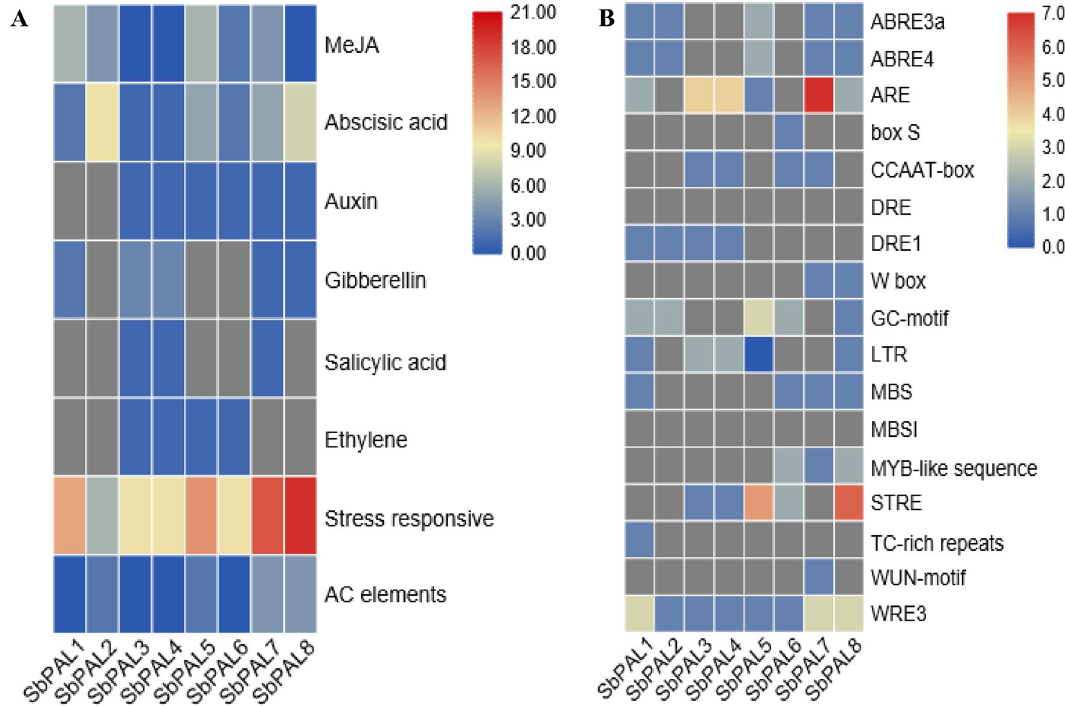
Figure 5. Heat map view of the sum of putative cis-acting elements related to phytohormones, stress response and lignin biosynthesis ( A ), and the specific number of stress related cis-acting elements ( B ) in eight sorghum PAL promoters. Color bars represent number of putative cis-acting elements present in each PAL gene. This heat map was created by the authors using TBtools (toolbox for biologists) v0.6741 from the data presented in Supplementary Table